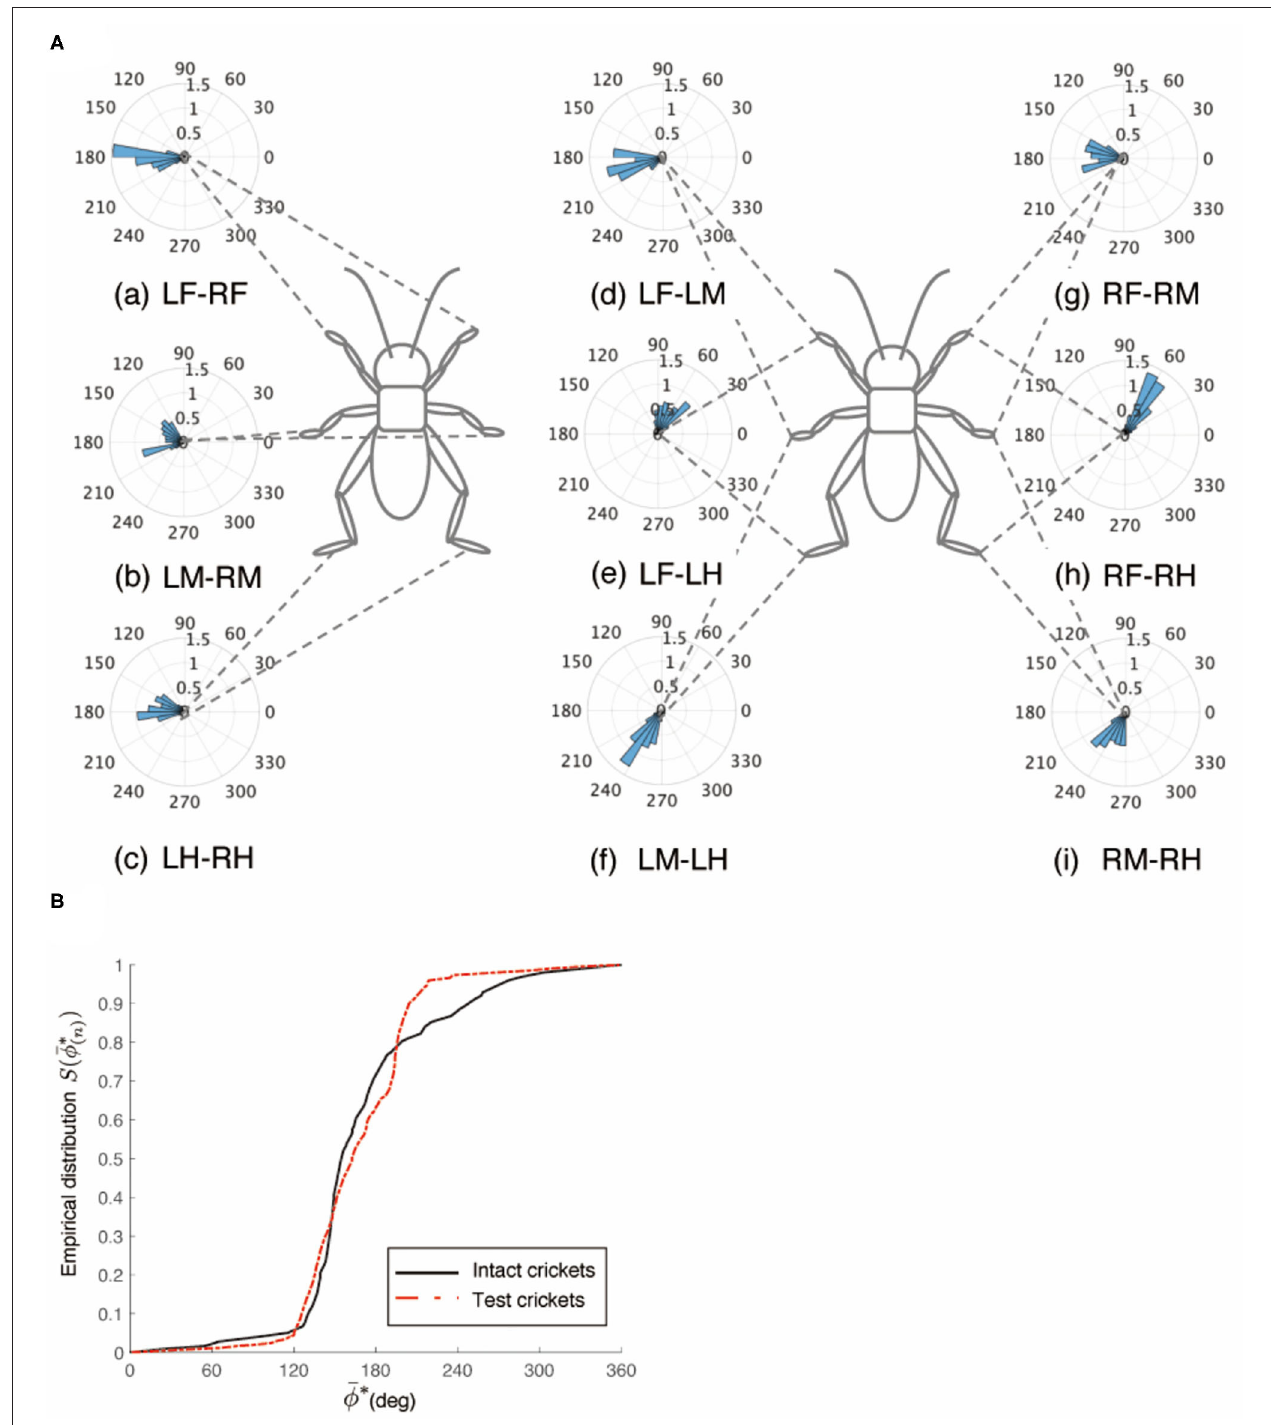
FIGURE 5 | Walking gait patterns of crickets in which left side of nerve connectives between SEG and prothoracic ganglion was cut. (A) Polar histograms indicate phase differences between two legs in test crickets ( N = 5). The polar histograms demonstrate that the test crickets exhibited a tripod gait pattern on the floating ball of the treadmill. (a–i) Phase differences between pairs of legs. (B) Comparison of the empirical distribution function of leg phase differences between left and right legs Φ LM − RM . The black line indicates the empirical distribution function of the intact crickets and the red line indicates that of the crickets in which only the left side of the nerve connectives between the metathoracic ganglion and abdominal ganglia was cut. LF, left foreleg; RF, right foreleg; LM, left midleg; RM, right midleg; LH, left hind leg; RH, right hind